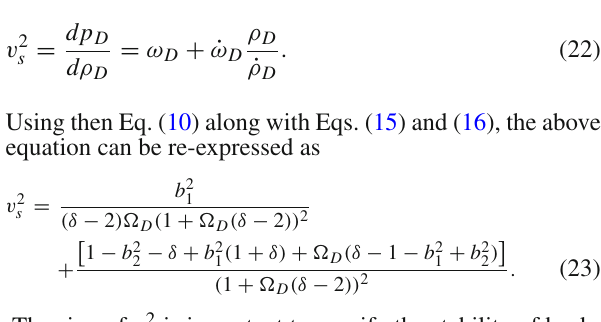
Fig. 1 The evolution of the THDE density parameter (cid:5) D , as a func- tion of z , is shown for the present model considering (cid:5) 0 different values of b 2 , b 2 and δ , as indicated in each 1 2